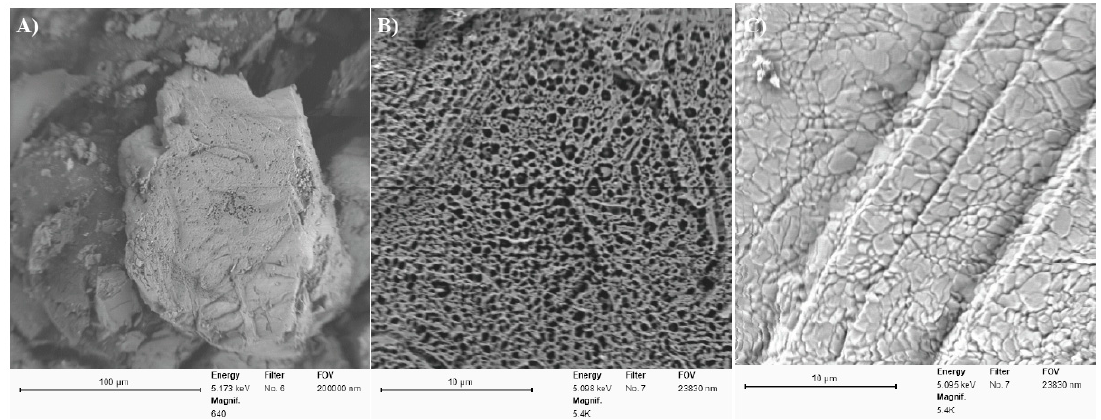
Figure 2. SEM images of polymeric composite (A) at low magnification (100 µm) and (B) high magnification (10 µm), and (C) high-magnification (10 µm) SEM images of iron-loaded polymeric composite.